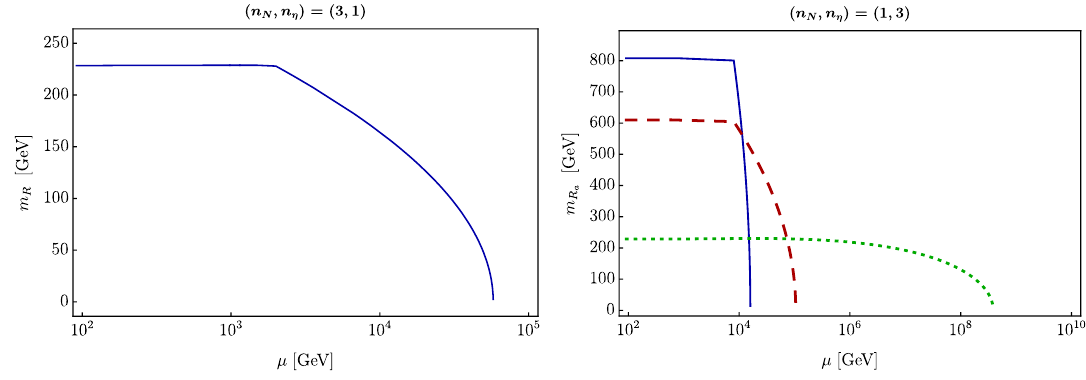
Figure 2 . Evolution of the CP-even scalar masses as a function of the energy scale (cid:22) in the (3 ; 1) and (1 ; 3) Scotogenic models. To the left, the CP-even scalar mass m R in the standard (3 ; 1) model with M N = (1 ; 1 : 5 ; 2) TeV, (cid:21) 2 = (cid:21) 3 = (cid:21) 4 = 0 : 1, (cid:21) 5 = 10 (cid:0) 9 and m 2 three CP-even scalar masses m R in the (1 ; 3) model with M N = 8 TeV, (cid:21) aaaa a (cid:21) aa = 10 (cid:0) 9 and m 2 = (200 2 ; 600 2 ; 800 2 ) GeV 2 , with the remaining scalar parameters set to (cid:17) 5